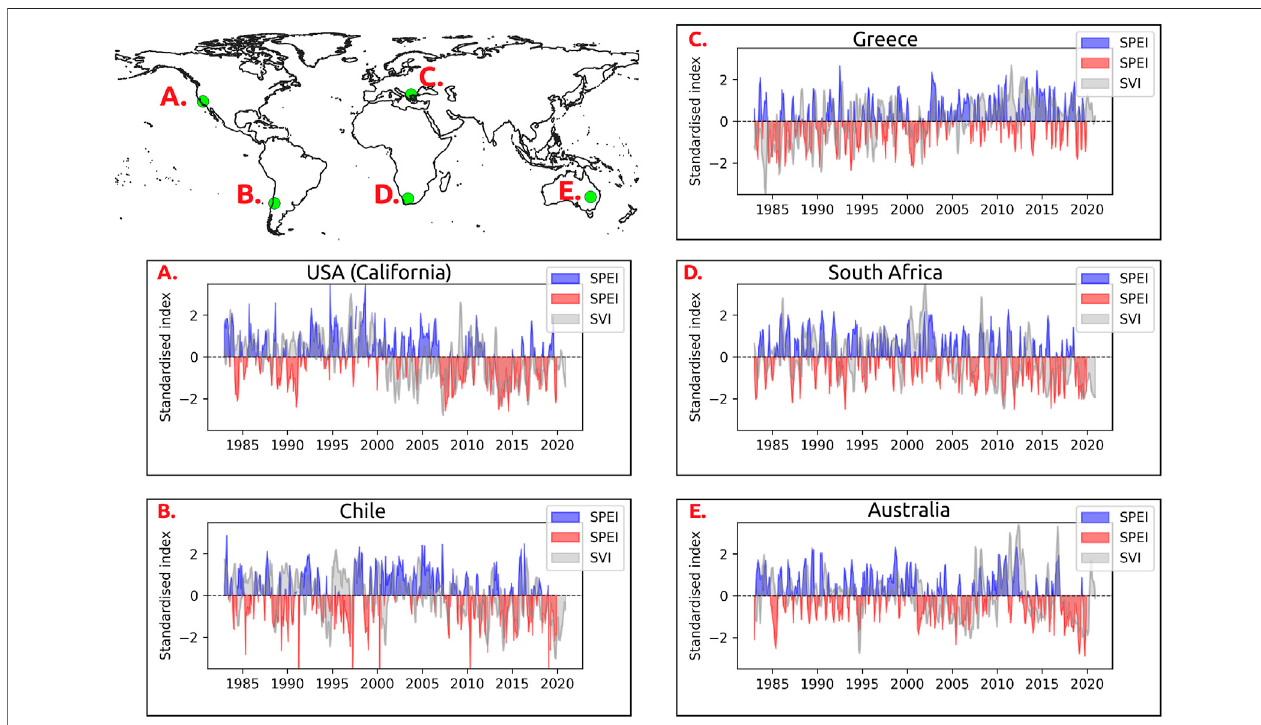
FIGURE 6| SPEI and SVI time seriesin differentlocations. Blue and red colours in plots correspondto wet and dry conditions in the SPEI time series, respectively, while grey colours correspond to the SVI series.